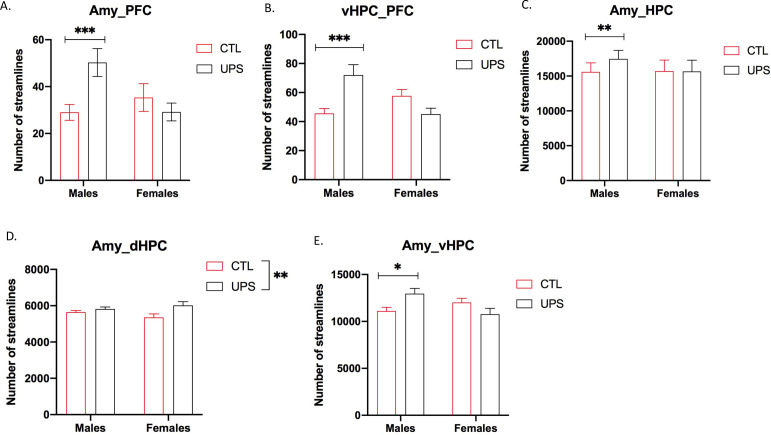
Fronto-limbic connectivity using an expanded cohort of animals (n = 12–13 per rearing and sex, total n = 50 mice).(A) Amygdala (AMY)–prefrontal cortex (PFC) connectivity revealed rearing by sex interaction (F (1, 46)=7.82, p=0.0075) that was driven by increased connectivity in unpredictable postnatal stress (UPS) males (p=0.0061) but not UPS females (p=0.63). (B) vHPC–PFC showed rearing by sex interaction (F (1, 46)=14.99, p=0.0003) that was due to increased connectivity in UPS males (p=0.0009) but not UPS females (p=0.17). (C) There was a significant rearing by sex interaction (F (1, 46)=5.57, p=0.023) for AMY–PFC connectivity that was driven by sex-specific increase in connectivity in UPS males (p=0.0034) but not UPS females (p=0.99). (D) AMY–dHPC showed significant rearing effect (F (1, 46)=7.33, p=0.0095), with no significant effects of sex or interaction. (E) AMY–vHPC connectivity revealed a significant rearing by sex interaction (F (1, 46)=8.98, p=0.0044) that was due to increased connectivity in UPS males (p=0.026) but not UPS females (p=0.19). Graphs represent mean and SEM, *p<0.05, **p<0.01, ***p<0.005.Figure 10—source data 1.Raw data for fronto-limbic connectivity in the extended cohort.